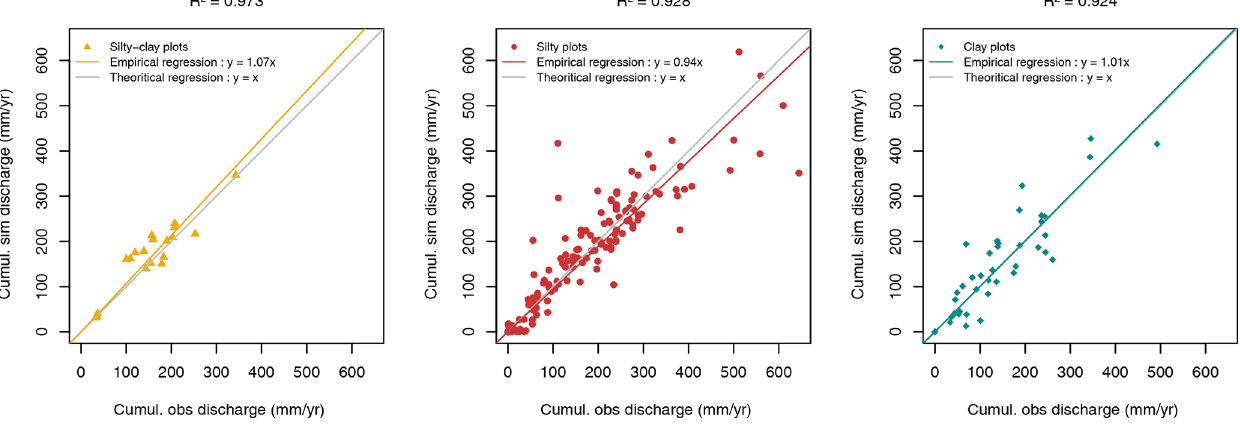
Figure 6. Comparison of the drained annual discharges between simulation and observation – each point represents the drained water quantity from a hydrological year for a given site, and all points have been classified by